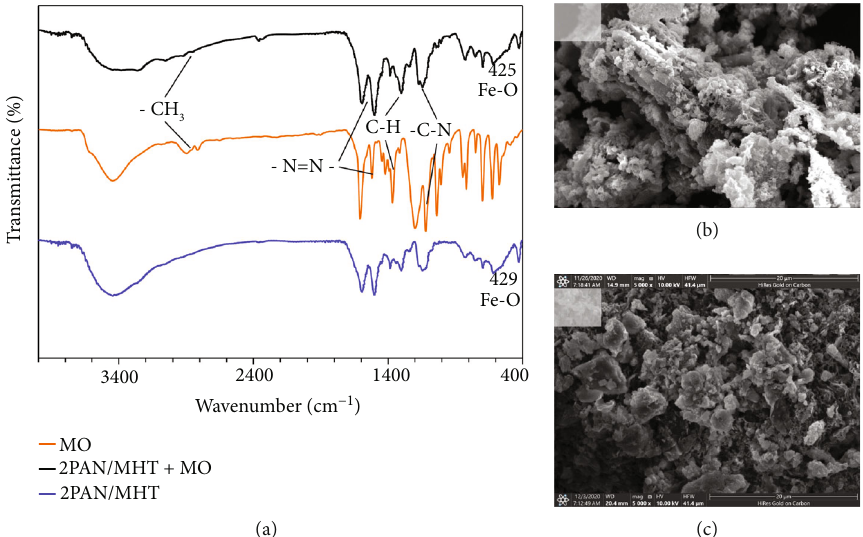
Figure 15: FT-IR spectra of MO (red line), 2 Pan/MHT (blue line), and 2 Pan/MHT after adsorption of MO ( — ) (a), SEM images of 2 Pan/ MHT (b), and 2 Pan/MHT after adsorption of MO